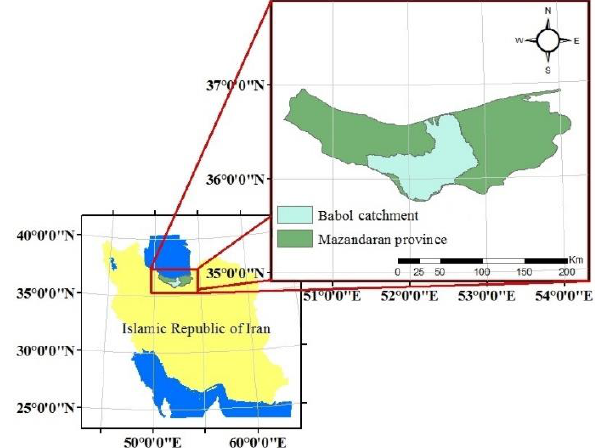
Figure 1. Location of Babol catchment in the Mazandaran province.